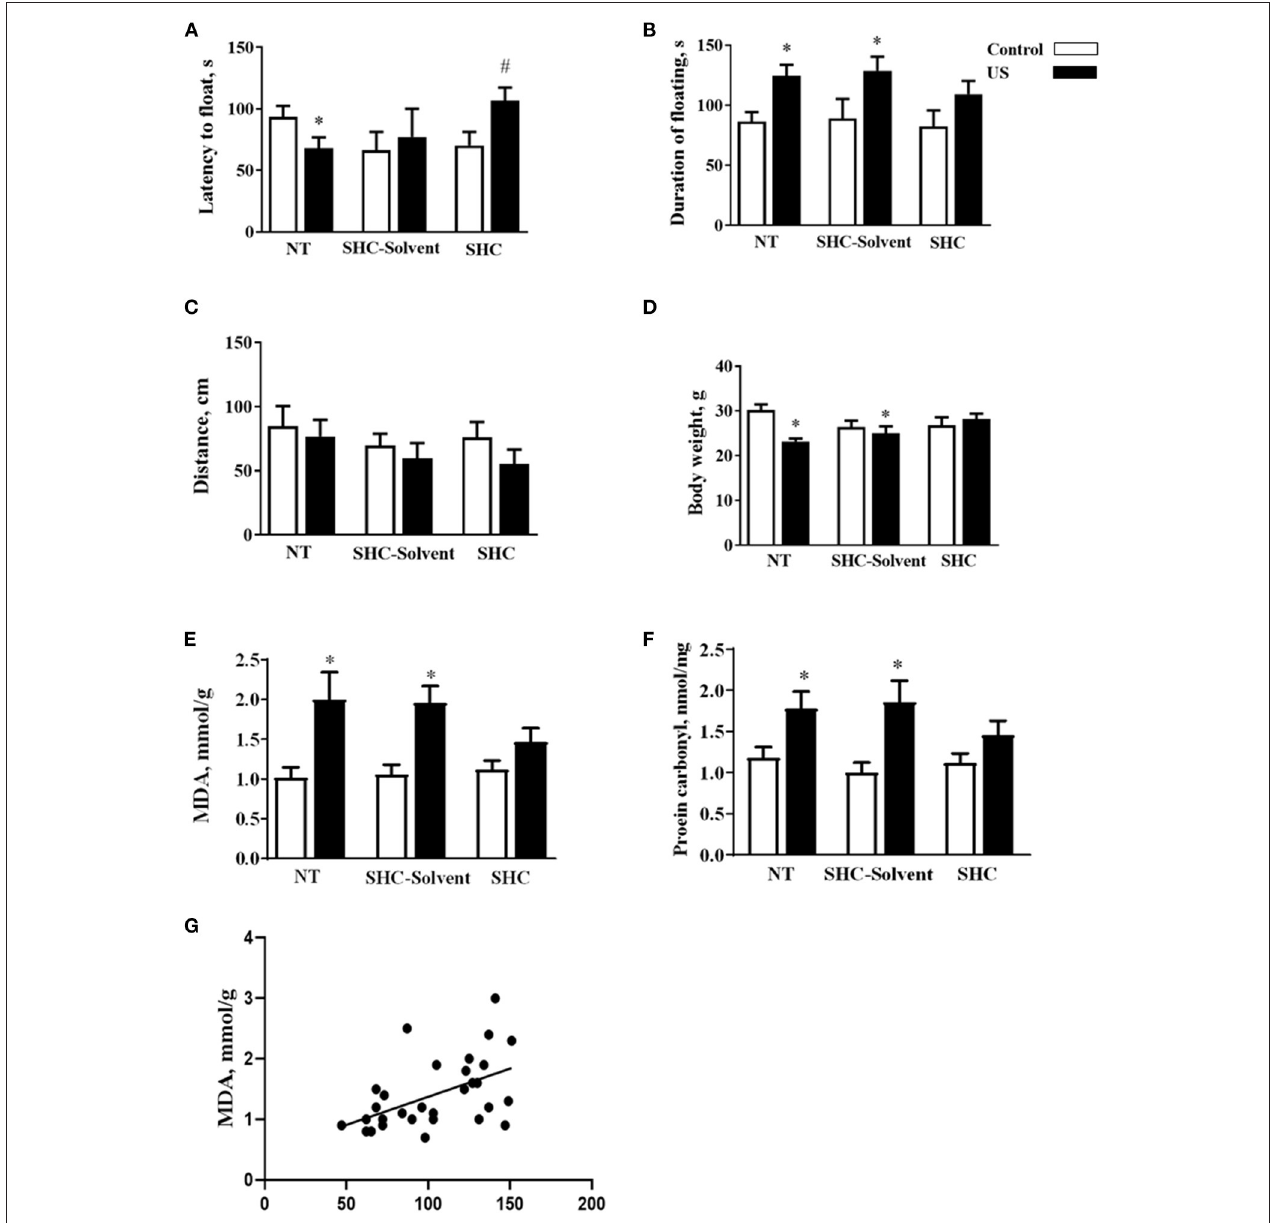
FIGURE 2 | Effects of herbal antioxidant treatment on behavioral changes and oxidative stress markers of BALB/c mice exposed to US. In comparison with controls, US nontreated and SHC solvent–treated mice showed (A) shortened latency to float, (B) a significant prolongation of the duration of floating that was now shown for SHC-treated stressed mice. (C) No significant group differences were found in distance traveled in the open field. (D) Nontreated and SHC solvent–treated US groups had significant body weight loss in comparison with controls that was not shown for the SHC-treated stress group. Concentrations of (E) MDA and (F) protein carbonyl were higher in stressed nontreated and SHC solvent–treated groups than in controls, no such differences were shown for US SHC-treated mice. MDA concentration in the prefrontal cortex was significantly correlated with (G) the duration of floating and (H) body weight. * p < 0.05 vs. nontreated nonstressed controls, # p < 0.05 vs. the nontreated stressed (US) group, two-way ANOVA and post-hoc Tukey’s test. NT, nontreated. Bars are mean ± SEM.